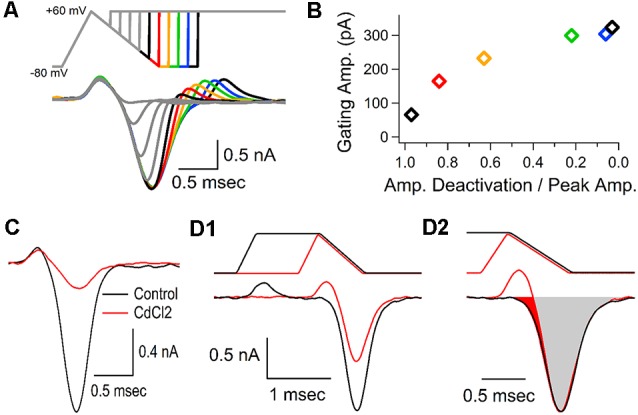
Gating current precedes the calcium channel response. (A) Representative traces, from a single cell, shown as an overlay of the calcium currents generated by 10 separate voltage-jumps to +60 mV, applied at regular intervals during an AP-like stimulus. Color traces following the peak of the calcium current show that the brief upward current re-appears as the stimulus returns to the holding potential, and the amplitude of the upward current increases as the amplitude of the remaining calcium current decreases. (B) Measurements from the data-trace in panel (A). For each voltage jump, the amplitude of the calcium current at the onset of the voltage jump was divided by the peak amplitude of the calcium current and graphed with the amplitude of the second upward current (gating current). Measurements are color-coded to match the traces from panel (A). (C) Cadmium (0.5 mM, 6 min) largely blocked the voltage-gated calcium channel response, but had little to no effect on the brief upward current. Traces shown are representative recordings from a single cell. (D1) To determine the calcium current in the absence of the brief upward current we compared the calcium current generated by an AP-like stimulus (black) to the response generated by an AP-like stimulus with a sustained depolarization that allows the upward current to return to baseline levels before the inward calcium current (red). Traces shown are representative recordings from a single cell. (D2) The response to the AP-like stimulation (D1, black) was scaled up to match the peak response from the prolonged AP-like stimulation. The filled red region indicates the portion of the calcium current that is affected by the upward gating current. In the representative cell shown here, the gating current obscured 5.4% (red area) of the inward calcium current.